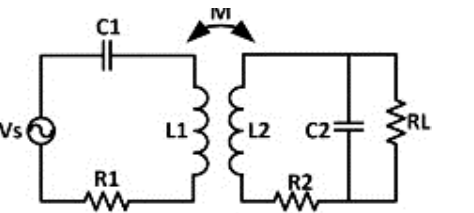
Figure 1. Typical wireless power transfer circuit.